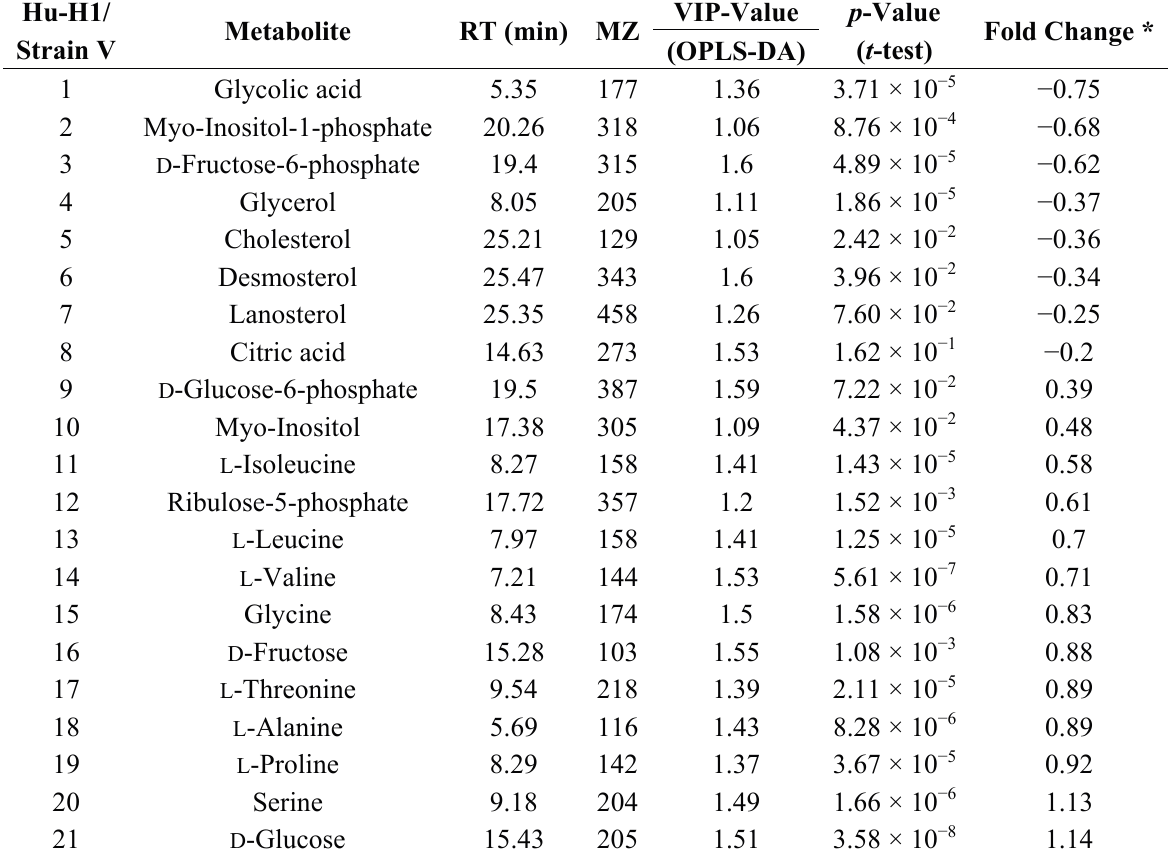
Table 4. Key differential metabolites detected by GC–MS for Hu-H1/Strain